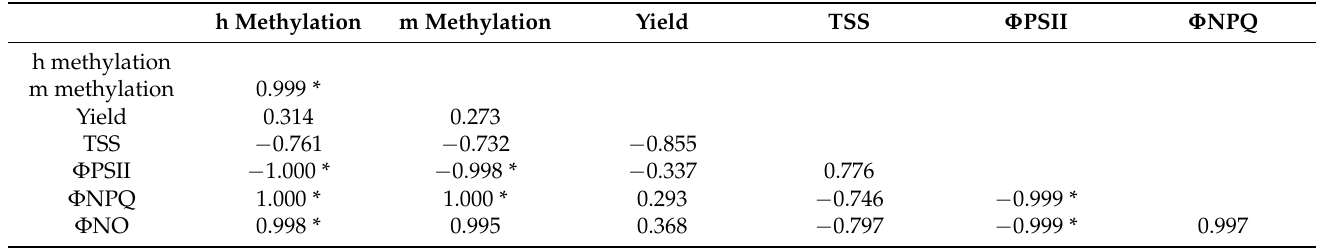
Figure 4. ( a ) The maximum efficiency of PSII photochemistry (Fv/Fm); ( b ) the non-photochemical quenching (NPQ) that reflects heat dissipation of excitation energy; ( c ) the photochemical quenching, which is the fraction of open PSII reaction centers (qp); and ( d ) the relative PSII electron transport rate (ETR) of rocket plants grown in non-heated tanks (12 ◦ C), in grid-heated tanks (22 ◦ C), and in solar panel-heated tanks (16 ◦ C). Error bars on columns are standard deviations based on six leaves from different plants. Different letters represent a significantly different mean for the same parameter ( p < 0.05). Table 3. Linear correlations between total methylation levels (hemimethylated CHG + fully methy- lated CG sites) (based on MSAP analysis), photosynthetic parameters ( Φ PSII, Φ NPQ and Φ NO), yield, measured in kg/m 2 (Karnoutsos et al. [42]), and total soluble solids (expressed as %brix). Significant differences were examined using a t -test (* p <